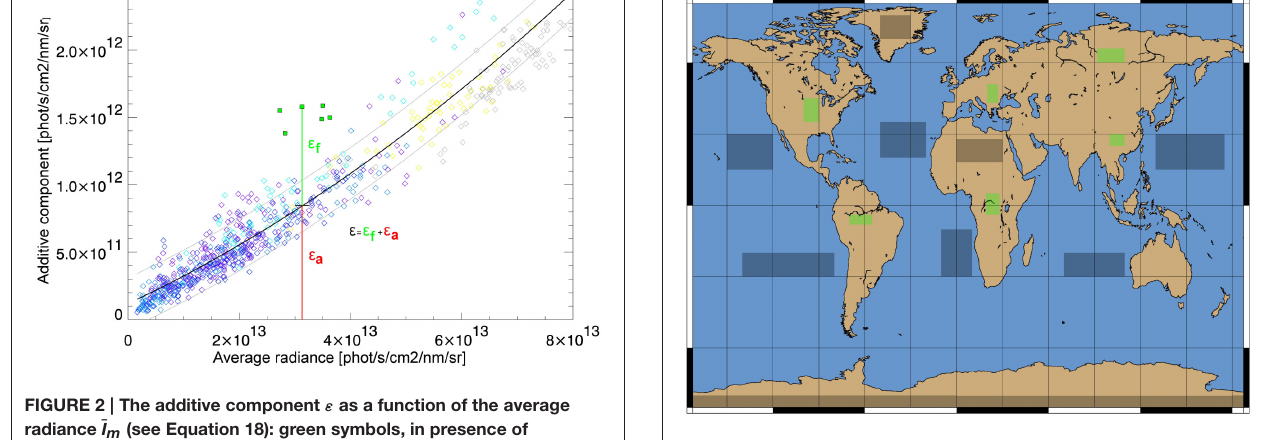
FIGURE 3 | Gray boxes are considered to be non-influenced by plant fluorescence and are used for the determination of ε . Green boxes are expected to contain only ground pixels where ε is dominated by fluorescence. They are only used for demonstration